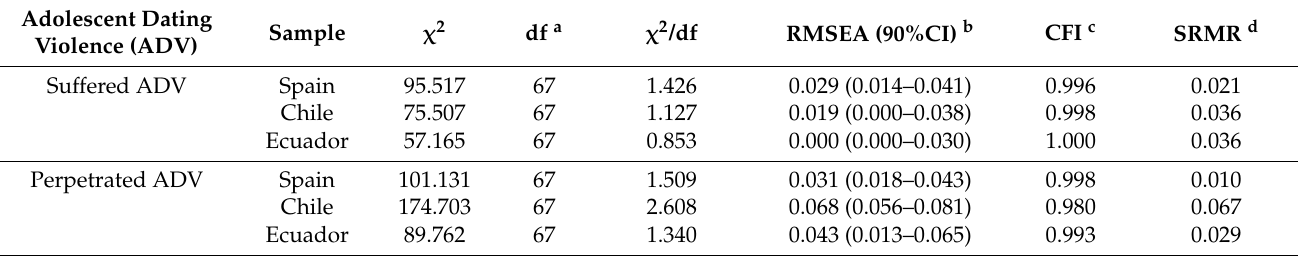
Table 2. Fit indices in Confirmatory Factor Analysis in each country.